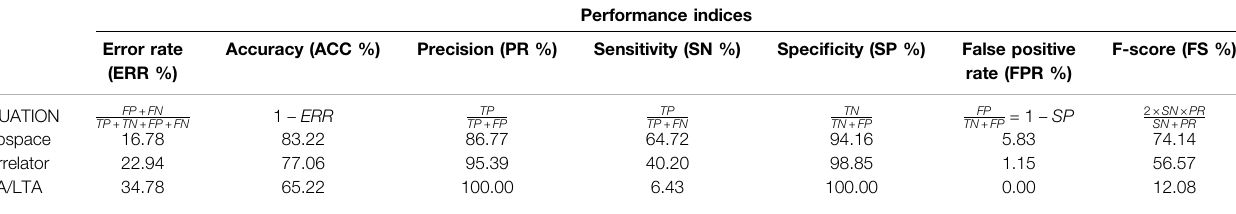
TABLE 2 | Performance indices, with relative equations, calculated from confusion matrices (see Figure 11 ) for subspace, correlator and STA/LTA triggering algorithms. Performance